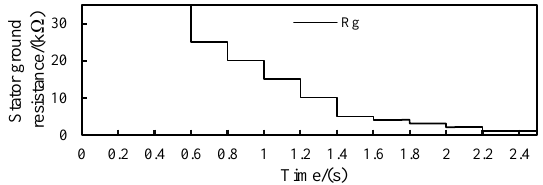
Figure 9. Change process of the stator grounding resistor.